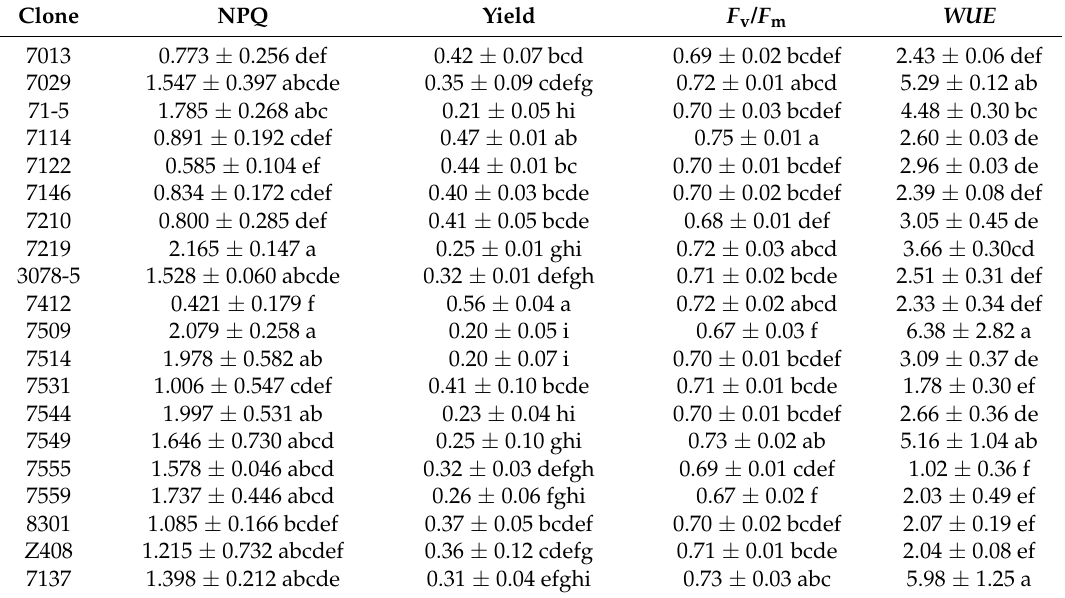
Table 4. Values of chlorophyll fluorescence parameters and WUE among teak